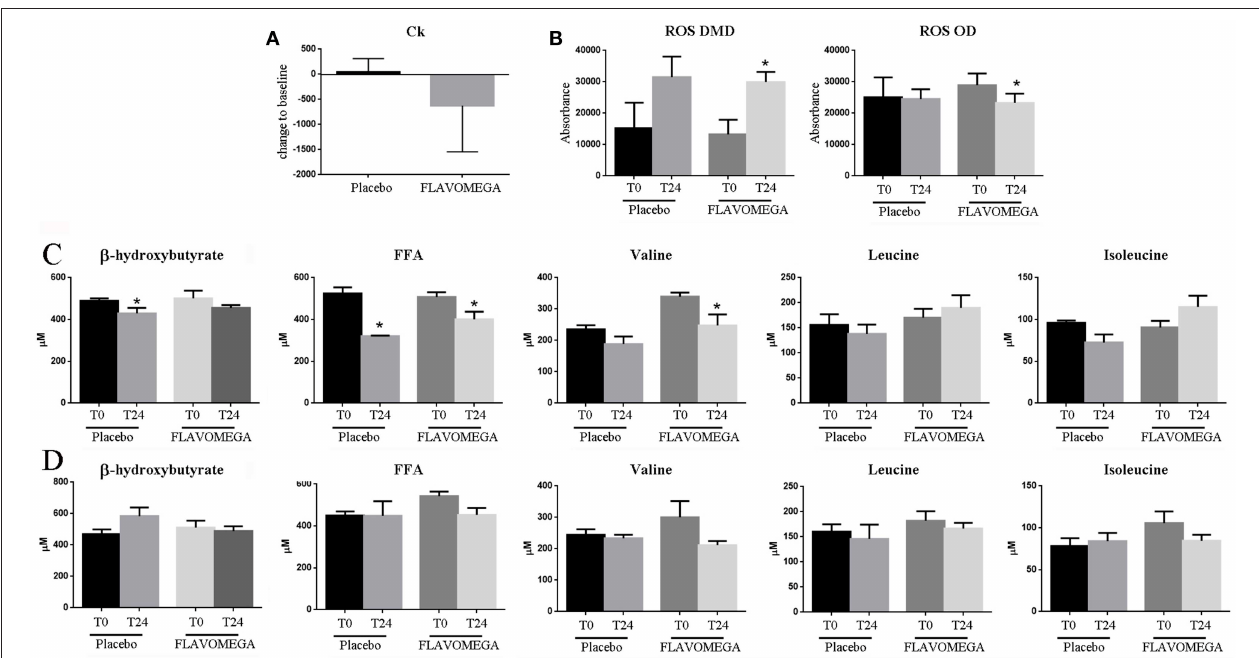
FIGURE 2 | (A) Ck serum levels in placebo and FLAVOMEGA-treated group as 1 T24wk-T baseline. (B) 1 T24wk-T baseline of serum levels of ROS in treated and untreated DMD and OD groups. (C) 1 T24wk-T baseline of serum levels β -hydroxybutyrate, FFA, and BCAA in DMD (C) and OD (D) groups. Paired t -test: * P <